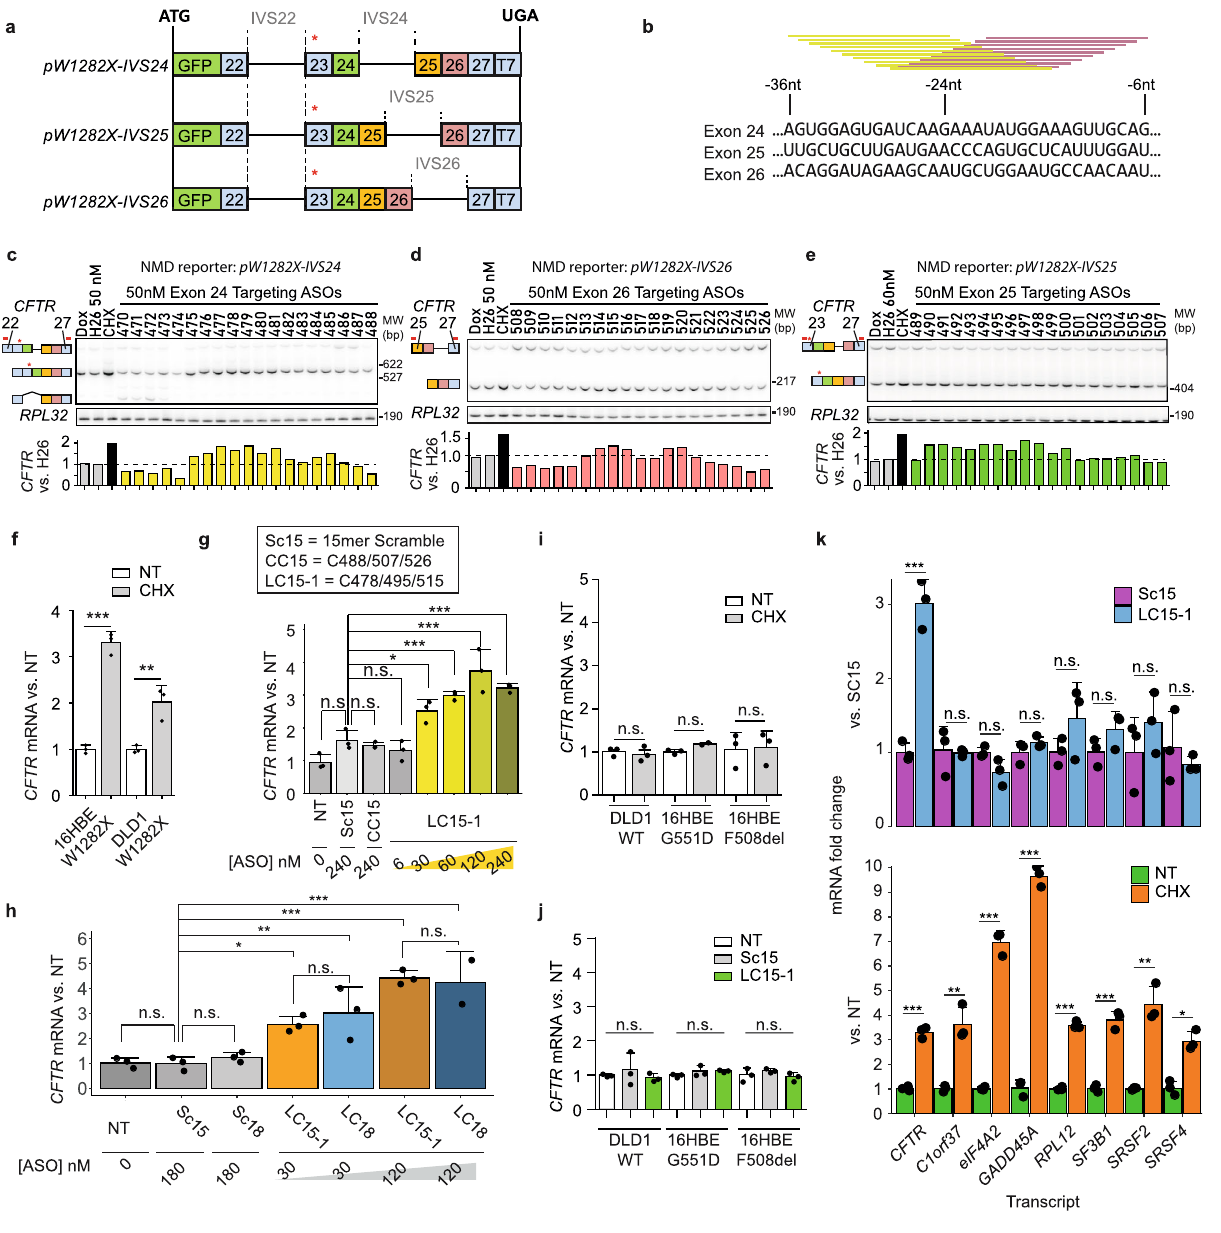
Fig. 1 Identi fi cation of NMD-inhibiting ASOs and assessment of their speci fi city. a Schematic of NMD reporters. The numbers show the CFTR exons in the NMD reporters. The red asterisk (*) indicates the location of the W1282X mutation. b Schematic of ASO screening. 19 MOE-PS-modi fi ed 15-mer ASOs (yellow and magenta bars) were designed to cover the presumptive EJC binding sites on exons 24, 25, and 26 at 1-nt resolution. U2OS cells stably expressing each NMD reporter were transfected with individual ASOs targeting EJC binding regions on CFTR exon ( c ) 24, ( d ) 25, or ( e ) 26, respectively. Reporter mRNA levels were measured by radioactive RT-PCR, using primers (red bars above the target exon) listed in Supplementary Table 5. f Effect of cycloheximide on CFTR expression in 16HBE-W1282X and DLD1-W1282X cells. g Effect of the 15-mer ASO cocktail LC15-1 on CFTR expression in 16HBE- W1282X cells. h Comparison between the effects of LC15-1 or LC18 on CFTR expression in 16HBE-W1282X cells. i Effects of cycloheximide on CFTR expression in DLD1-WT, 16HBE-G551D, and 16HBE-F508del cells. j CFTR mRNA levels in DLD1-WT, 16HBE-G551D, and 16HBE-F508del transfected with Sc15 or LC15-1 at a nominal total concentration of 120 nM. k Endogenous NMD-sensitive mRNA levels in 16HBE-W1282X cells treated with cycloheximide, 120 nM Sc15 or LC15-1. All mRNA levels in ( f ) – ( k ) were measured by RT-qPCR; CFTR mRNA levels were measured using forward and reverse primers targeting exon 22 and exon 23, respectively. RPL32 served as internal reference for all panels except h , in which HPRT served as internal reference. NT = No treatment; Dox: doxycycline 1 μ g/mL; Sc15/18 = 15/18-mer Scramble ASO; CC15 = ASO cocktail C488/C507/C526; LC15-1 = ASO cocktail C478/C495/ C515; LC18 = 18-mer ASO cocktail C24/25/26; CHX = 1-h incubation with 100 μ g/mL cycloheximide. Data are represented as mean values ± SD. All data points represent independent biological replicates. c – e ( n = 1). f – k ( n = 3 for all treatments, except n = 2 in LC18-mer 120 nM in h ). For all statistical tests, n.s. P > 0.05, * P < 0.05, ** P < 0.01, *** P < 0.001. f , h (LC15-1 vs LC18), i , k two-tailed Student ’ s t -test. g , h One-way ANOVA with Dunnett ’ s post-test, versus Sc15. j One-way ANOVA. Source data are provided as a Source Data